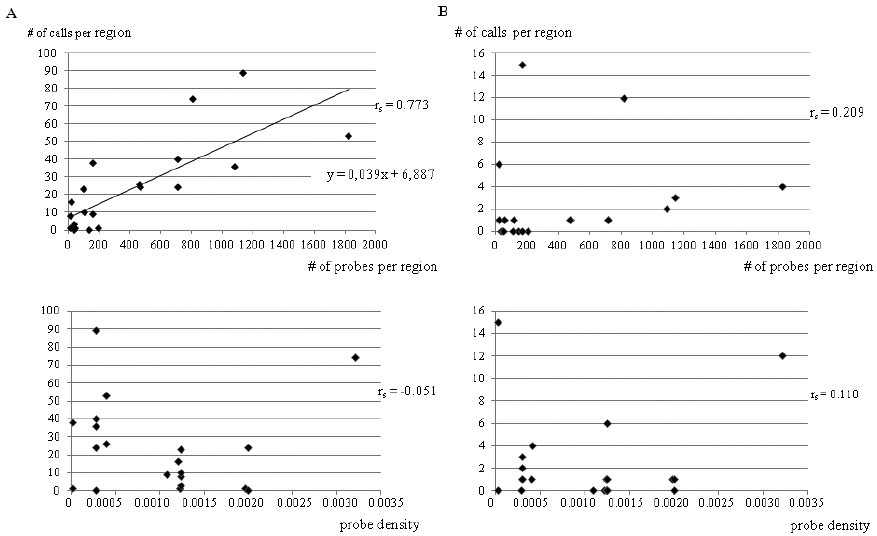
Figure 3. Aberration calls and probes correlations. Correlation between the number of calls detected in each high density region and the number of probes selected in each region ( upper ) or the probe density (number of probes/size) of the selected region ( bottom ) considering any calls, including: single probe calls ( A ); or only multi probes calls with MAAD > 0.3 ( B ). Redundancy of probes covering the same target sequence might instead create problems in the hybridization and thus false results, as we could observe in a preliminary design.